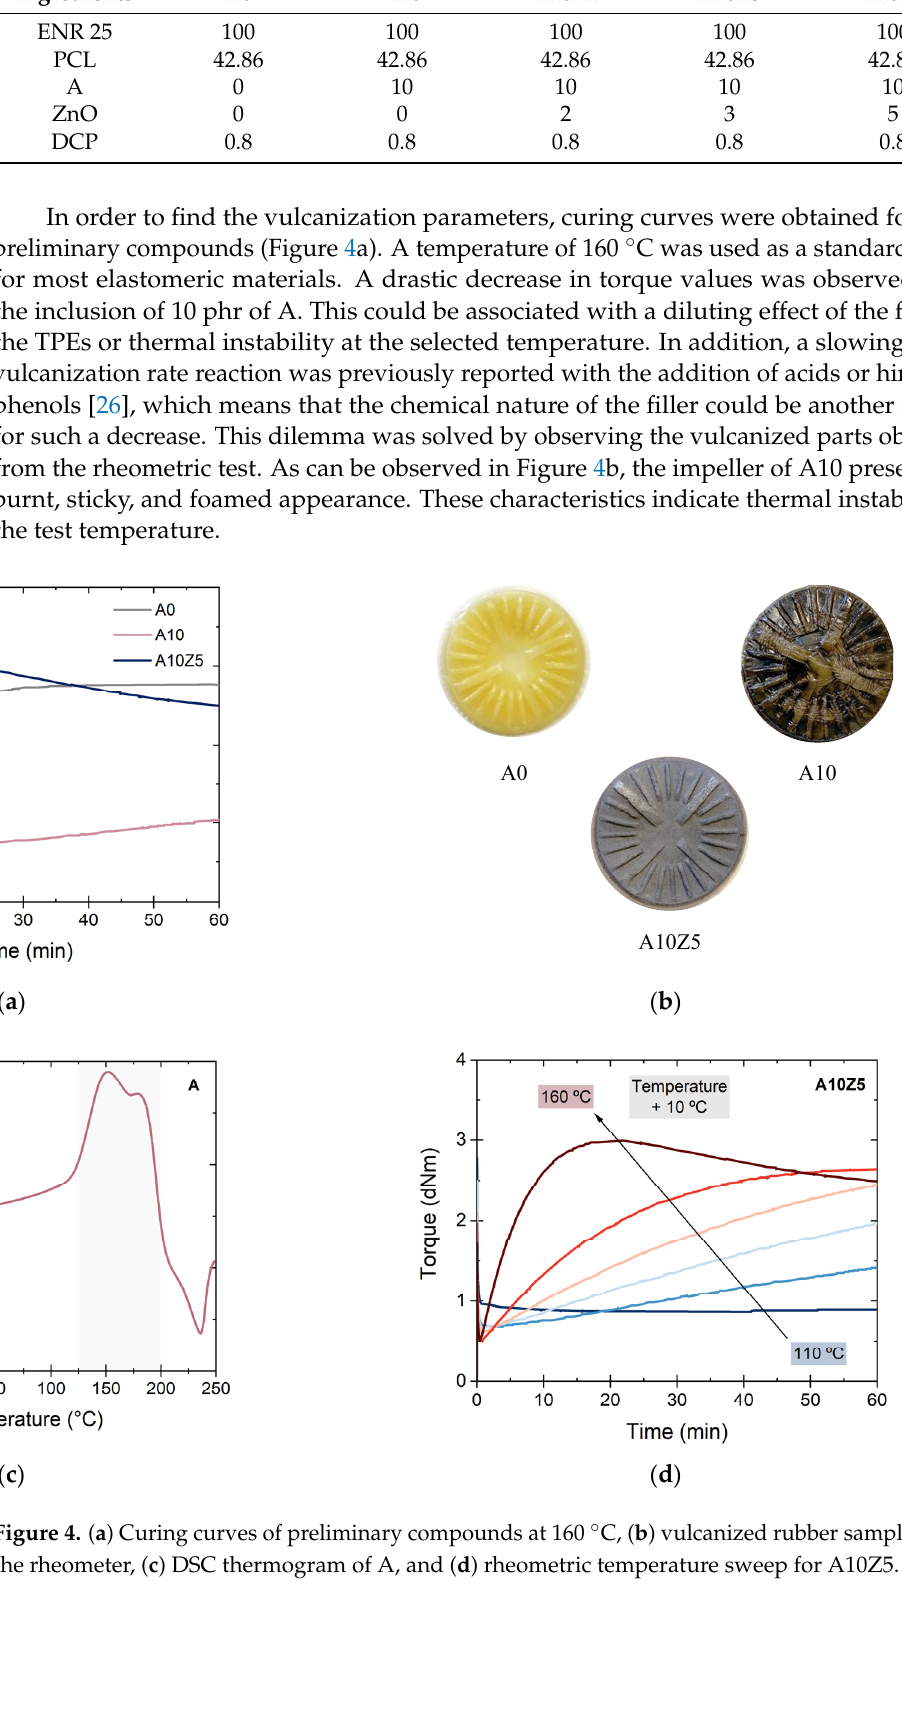
Table 1. Rubber recipes of TPEs reinforced with 10 phr of A and ZnO (in phr). Ingredients